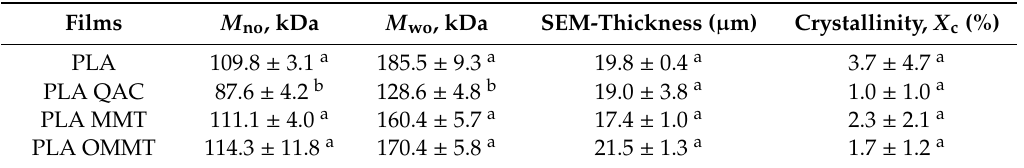
Table 1. Initial characterization of polylactic acid (PLA), PLA QAC, PLA montmorillonite (MMT) and PLA Organomodified montmorillonite (OMMT) films.